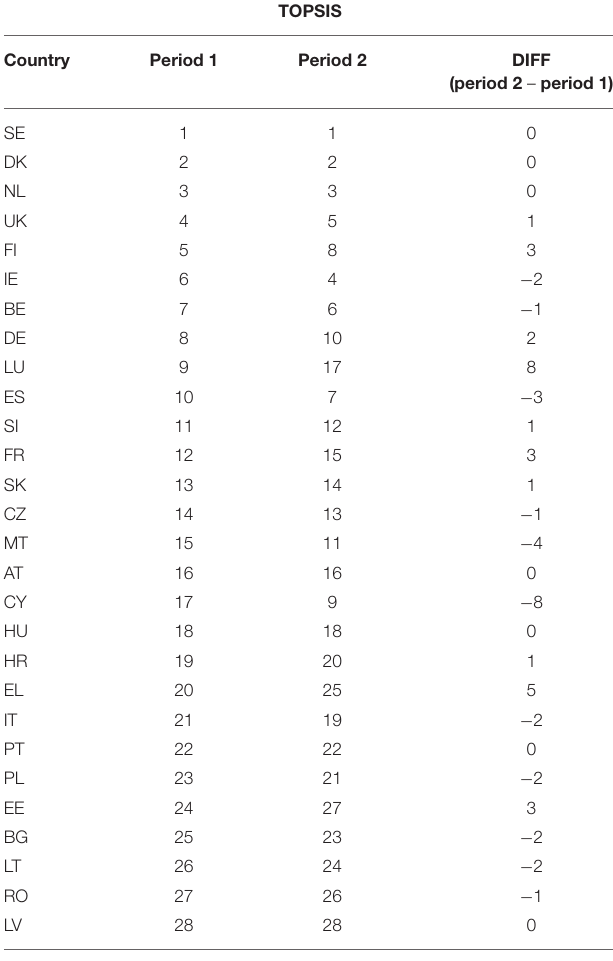
TABLE 4 | Ranks of the EU countries by the TOPSIS